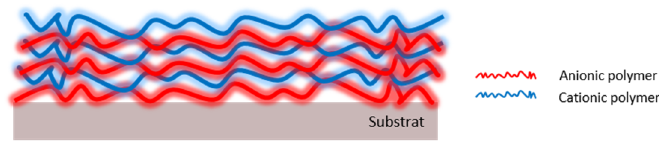
Figure 6. Polyelectrolyte multilayer structure.